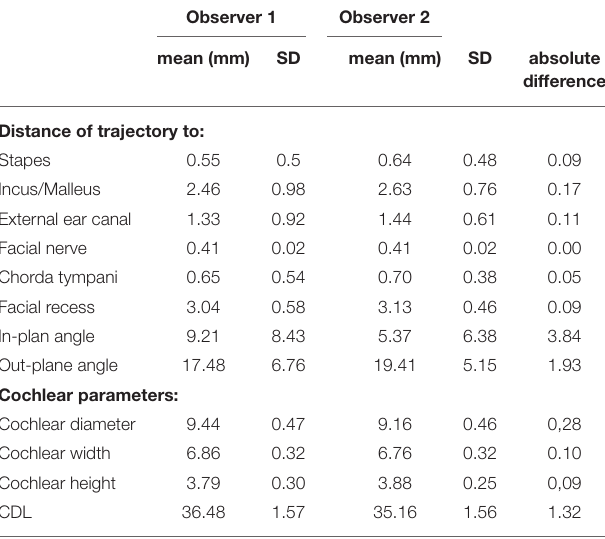
TABLE 2 | Cochlear parameters and distance of planned trajectory to critical anatomic structures.